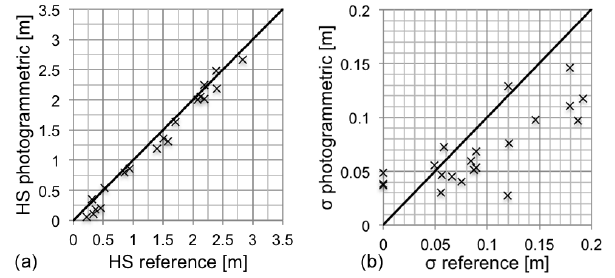
Figure 8. Statistical evaluation of the HS measurements (left panel) and the standard deviations σ of HS within a reference plot (right panel).